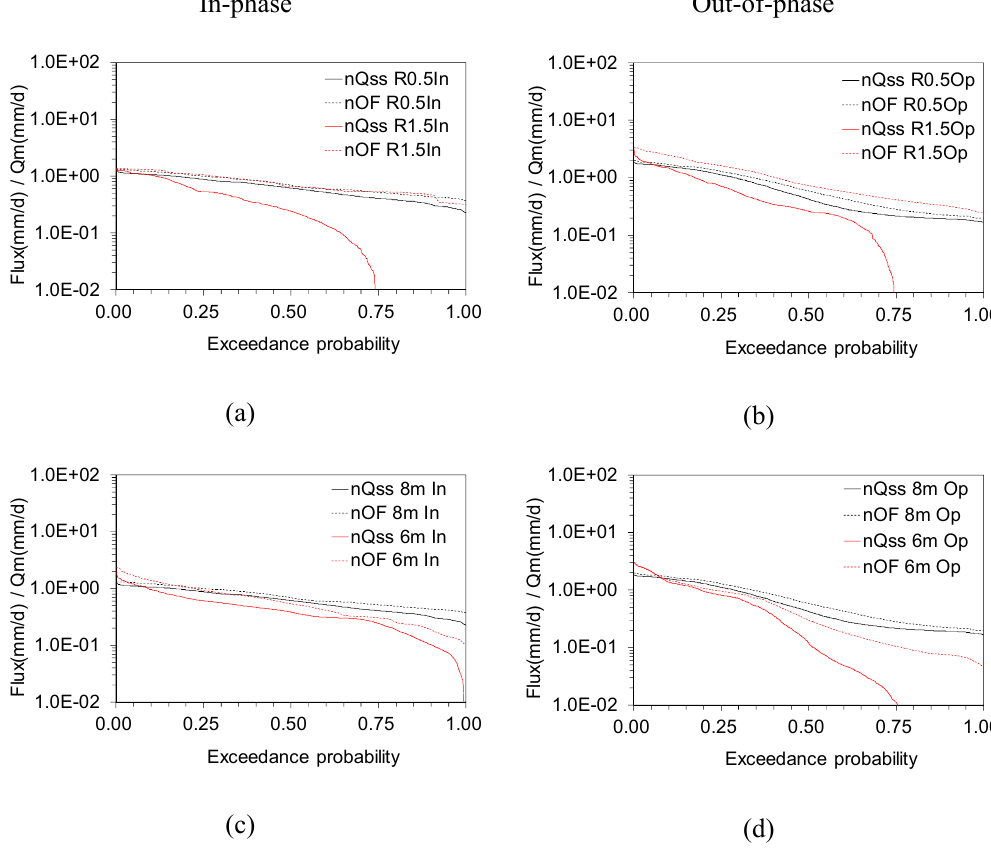
Fig. 6. Relationships between FDCs of the outflow OF and subsurface flow Q ss normalized by mean annual daily flow Q m : (a) seasonal peaks of P and PET are both in phase but dryness indices are 0.5 and 1.5; (b) seasonal peaks of P and PET are both of opposite phase and dryness indices are 0.5 and 1.5; (c) seasonal peaks of P and PET are both in phase but soil depths are 6m and 8m; and (d) seasonal peaks of P and PET are both of opposite phase but soil depth is 6m and 8m. The difference between Q m and OF is equal to the evapotranspiration from the saturated fraction of the ground surface. Default soil type, soil depth, topographic gradient, and dryness index are, respectively, silty loam, 8m, 0.006, and